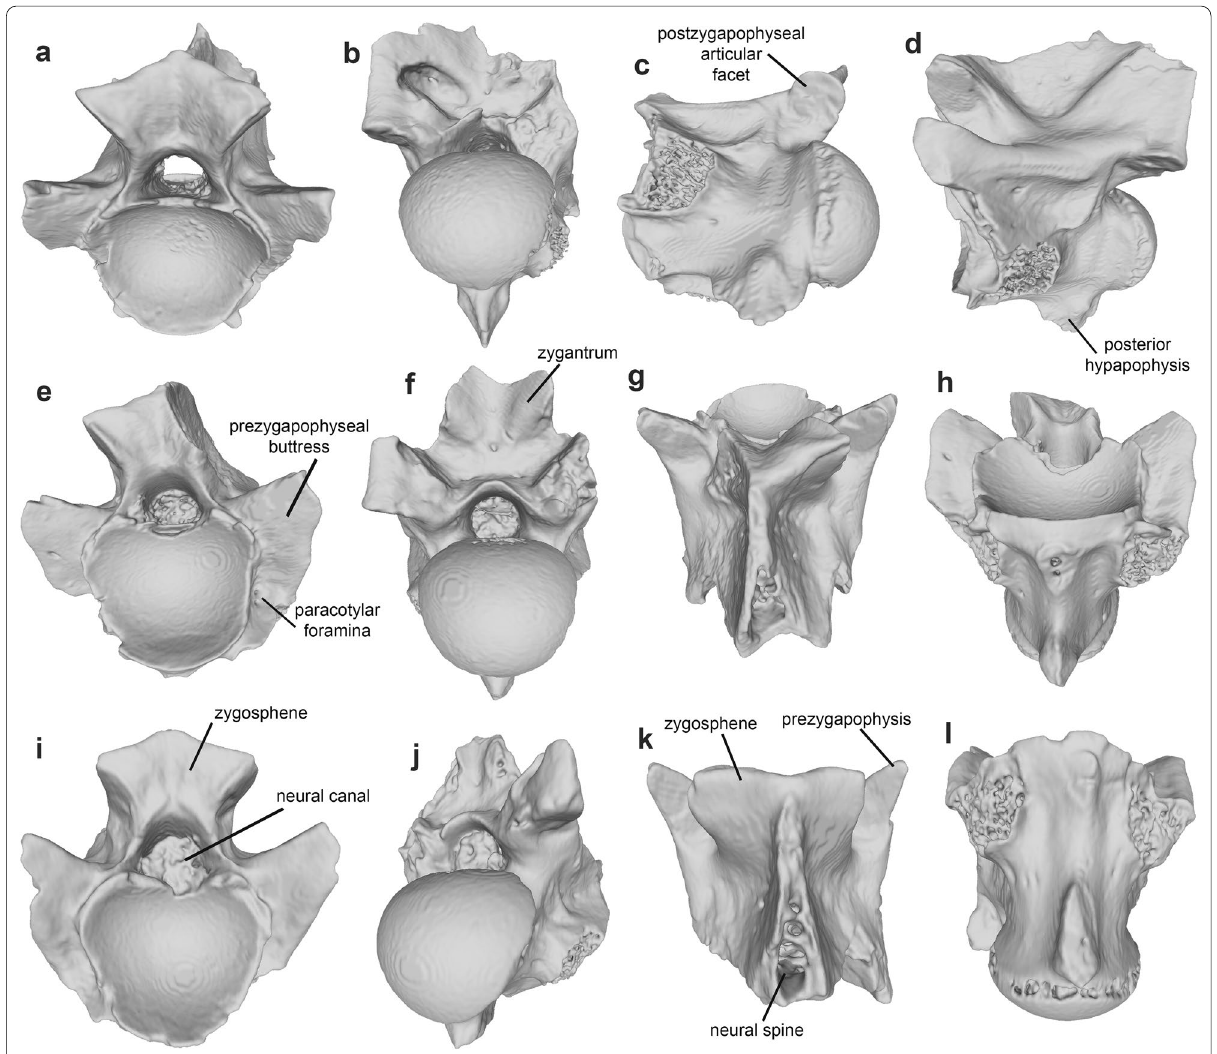
Fig. 9 3D models of anterior mid- or mid-trunk vertebrae: a–d UM KPO 30 in anterodorsal ( a ), posterior ( b ), left ventrolateral ( c ), and left lateral ( d ) views; e–h UM KPO 21 in anterior ( e ), posterior ( f ), dorsal ( g ), and anteroventral ( h ) views; i–l UM KPO 24 in anterior ( i ), right posterolateral ( j ), dorsal ( k ), and ventral ( l ) views. Specimens not to the same